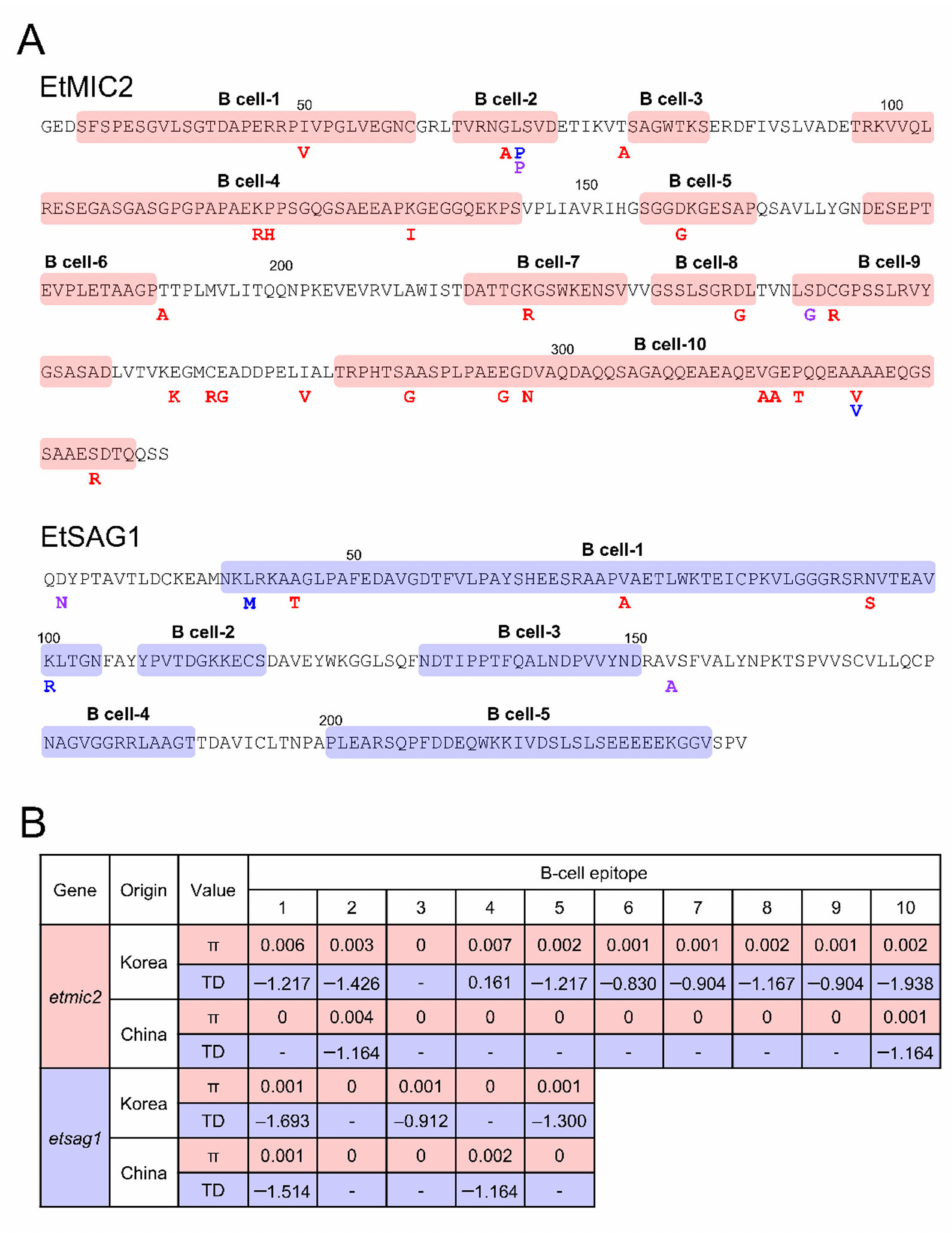
Figure 5. Association between genetic diversity of EtMIC2 and EtSAG1 and host immune pressure. ( A ) Positions of amino acid changes found in the putative B cell epitopes in EtMIC2 and EtSAG1. The putative B cell epitopes were boxed with pale red (EtMIC2) and pale blue (EtSAG1). Polymorphic amino acid residues detected in EtMIC2 and EtSAG1 were presented under the mutated positions with different colours (Red, Korean; Blue, Chinese; Purple, Indian). ( B ) Nucleotide diversity and natural selection analysis. Nucleotide diversity ( π ) and Tajima’s D (TD) values for each B-cell epitope region of EtMIC2 and EtSAG1 were analysed using the DnaSP